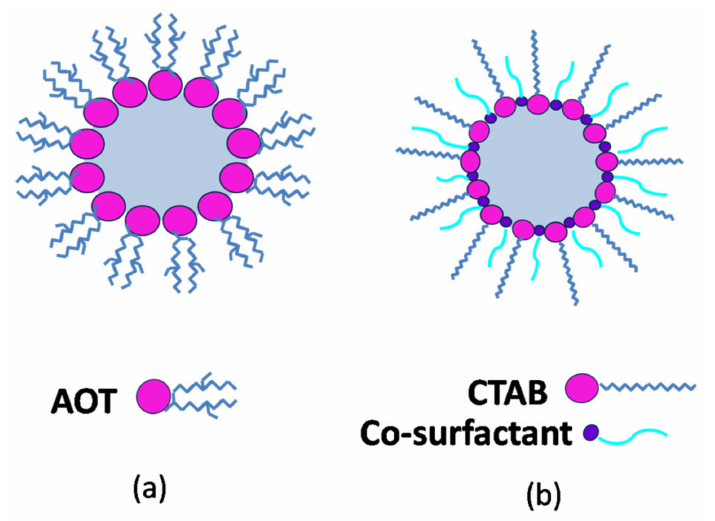
Figure 4. Schematic cross-section through ( a ) Aerosol Orange T (AOT)-based RM; ( b ) cetyltrimethy- lammonium bromide (CTAB)-based